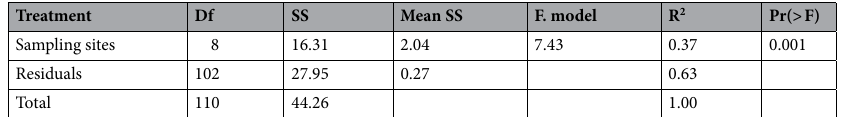
Treatment Df SS Mean